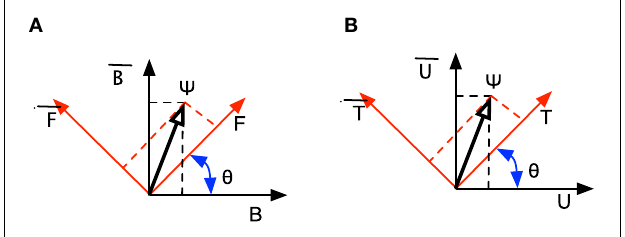
FIGURE 1 | Incompatible perspectives in a relevance judgment. (A) Incompatible perspectives in the Linda example. (B) Incompatible perspectives in judging document